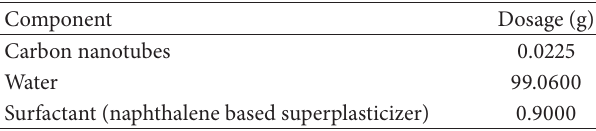
Table 5: Composition of CNT dispersions.